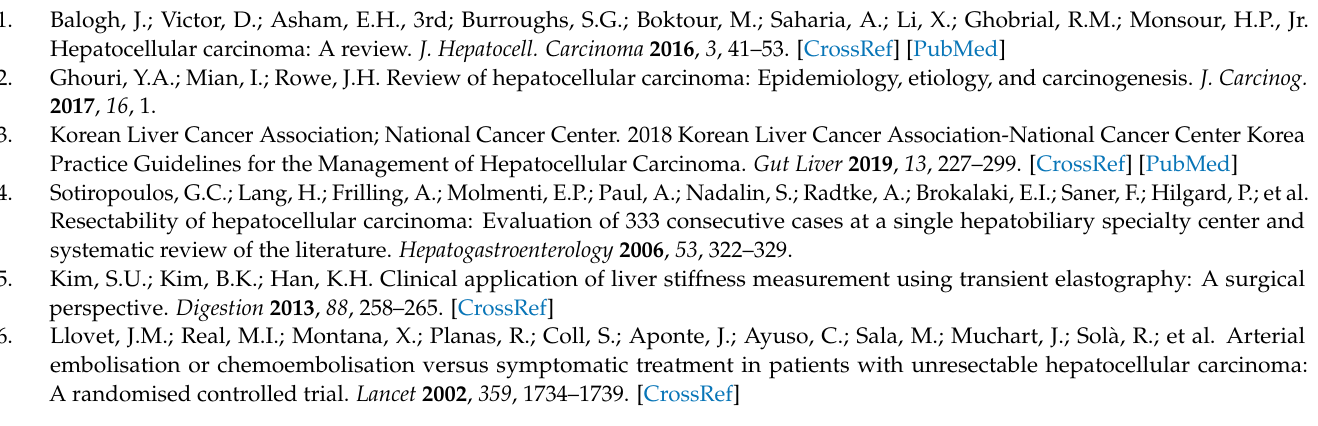
Figure S1. The Kaplan–Meier curves of progression according to BCLC stages; Figure S2. The Kaplan– Meier curves of (a) overall survival and (b) progression-free survival according to different treatment modalities following TARE